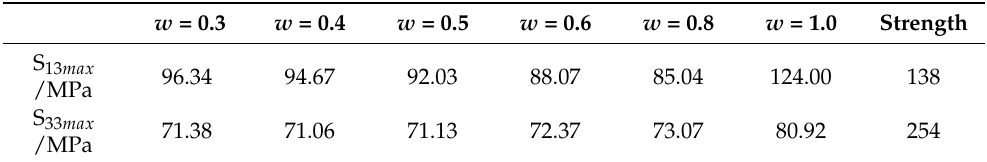
Figure 7. Typical stress distribution of the repaired plate under an in-plane compression of 520 kN. Table 3. Maximum interlaminar shear stress (S 13 ) and through-thickness tensile stress (S 33 ) in the cases ( n = 6, d = 2.5 mm, different w